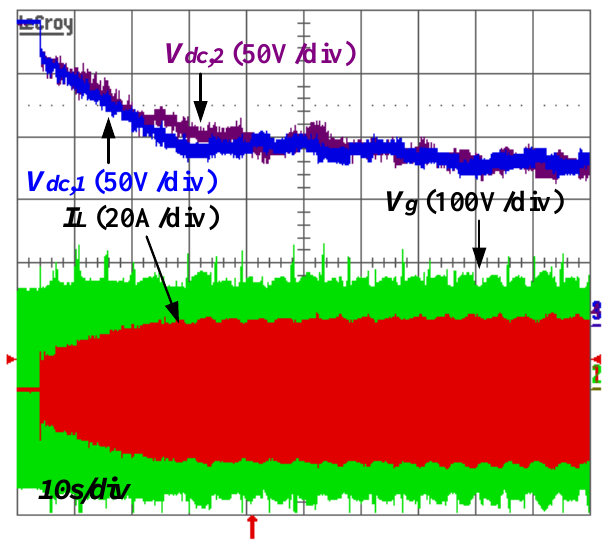
Figure 17. Experimental results for maximum power point tracking.